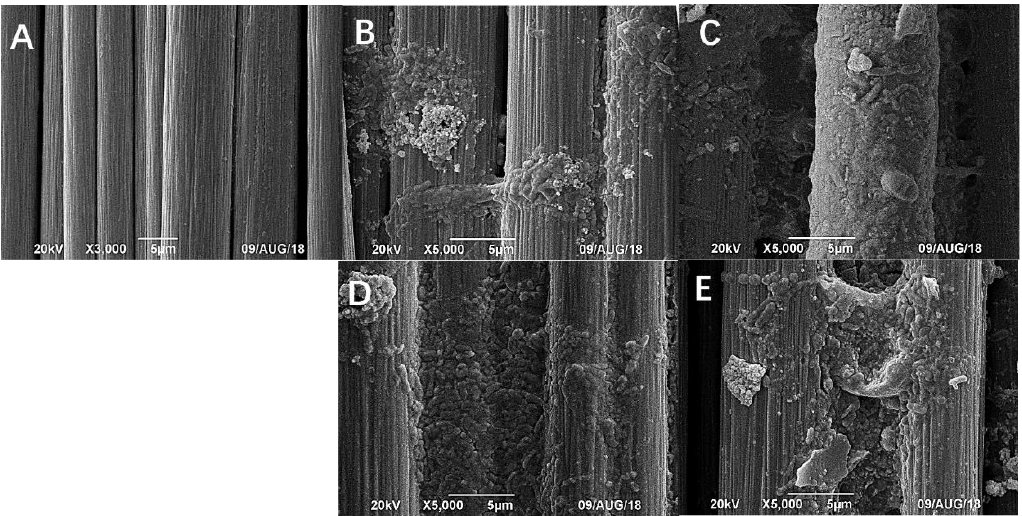
Figure 4. SEM of the bioelectroactive biofilms enriched with different energy substrates. ( A : abiotic control; B : glucose; C : acetate; D : ethanol; E : lactate).